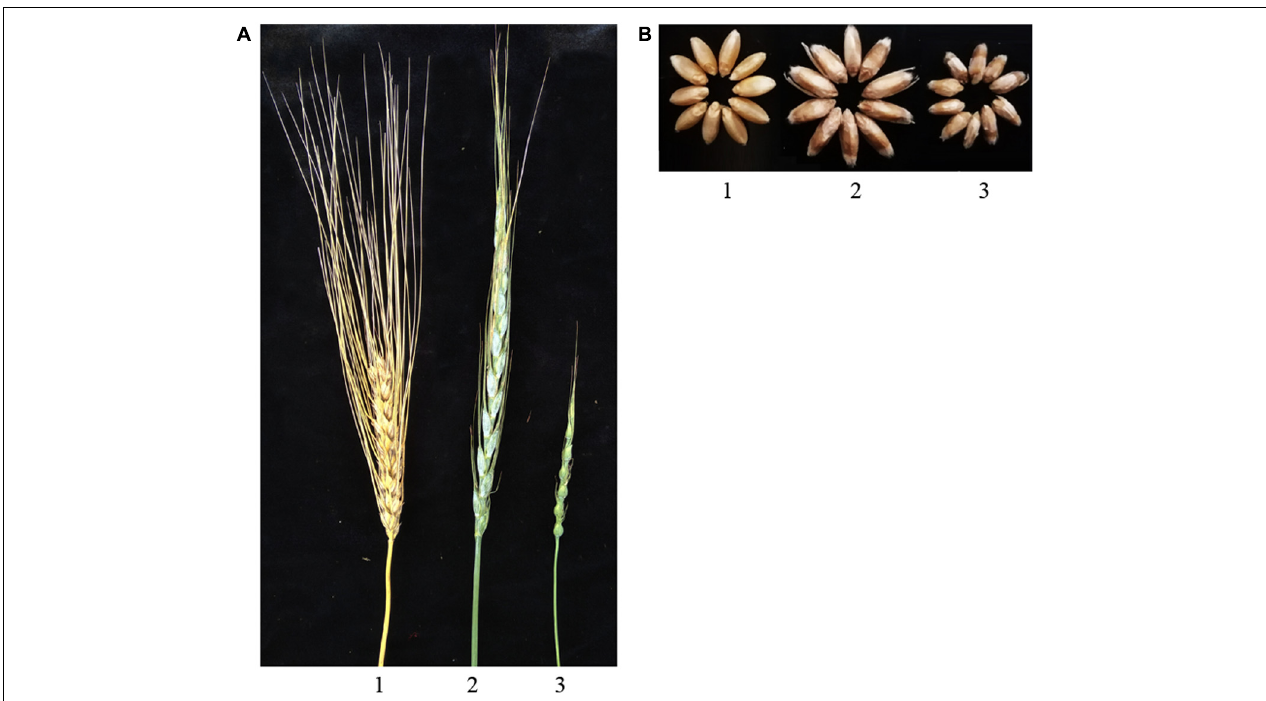
FIGURE 2 | Spike (A) and seeds (B) morphology. 1–3 are T. turgidum var. turgidum cv. Langdon, amphiploid, and Ae. ventricosa cv. RM271, respectively.